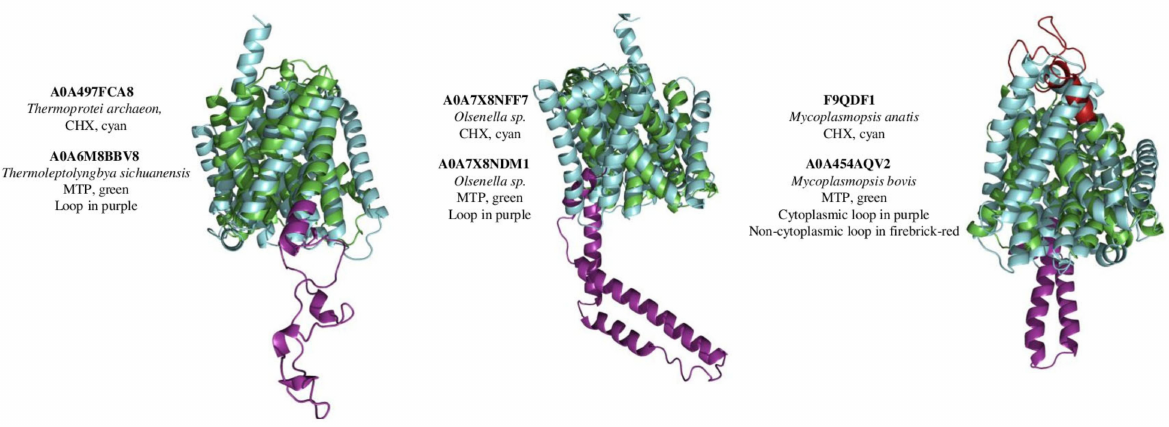
Figure 3. Alignment of structural models of MTP domain-containing proteins with Na/H Exchanger domain. MTPs (green) (with loops) from cyanobacteria Thermoleptolyngbya sichuanensis were aligned with Na/H exchanger from archaea Thermoprotei archaeon (cyan) (alignment score 146). MTP from Olsenella sp. (green) was aligned with Na/H Exchanger from the same bacteria (alignment score 152), and MTP from Mycoplasmopsis bovis (green) was aligned with Na/H exchanger from Mycoplasmopsis anatis (cyan) (alignment score 221). MTPs’ non-cytoplasmic loop is represented with firebrick-red, cytoplasmic with purple